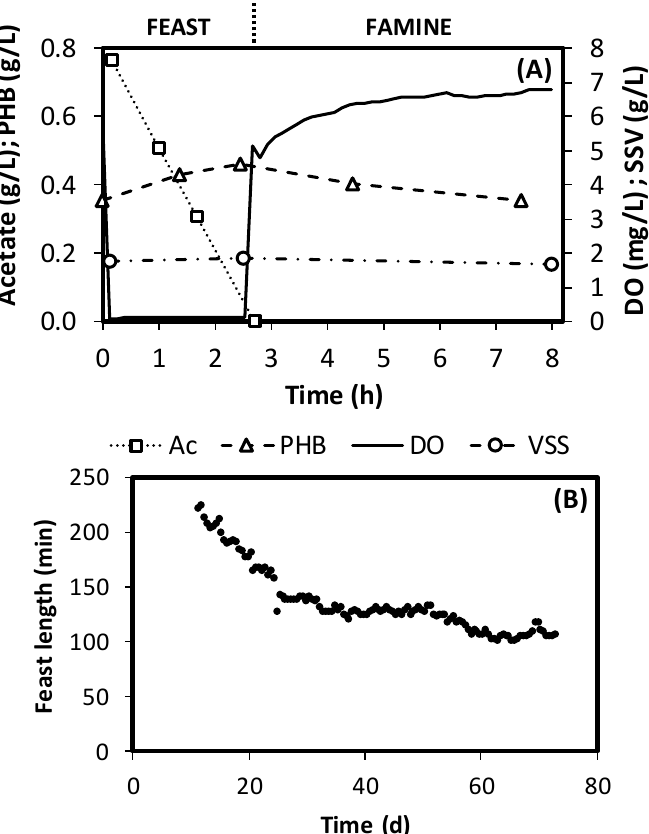
Figure 2. ( A ) Typical behaviour of an operation cycle (SBR #2). ( B ) Evolution of the feast length during operation of SBR #10.